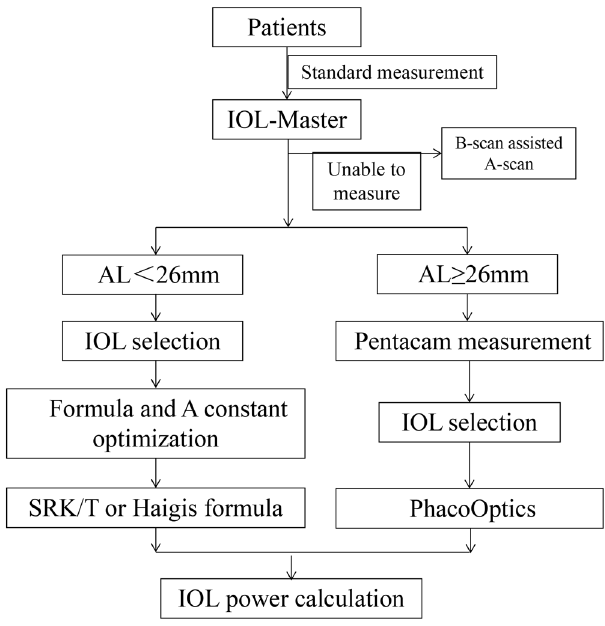
Figure 3. Standard flow of the intraocular lens (IOL) power calculation process. After quality control circle, the process of the IOL power calculation was standardized for cataract patients with different axial lengths